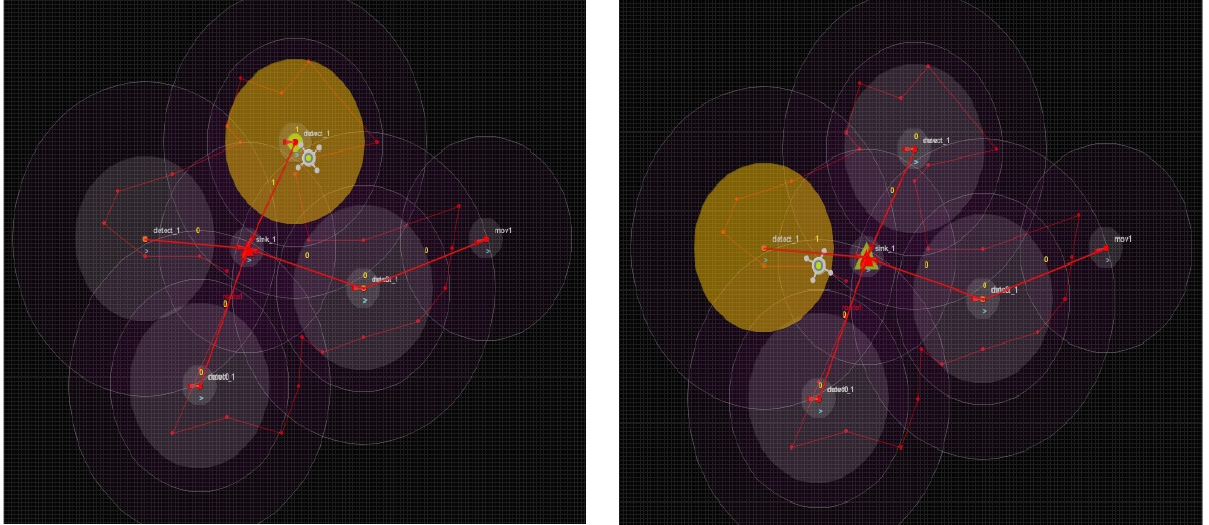
Figure 10. Drone chasing flying moths in different clusters.